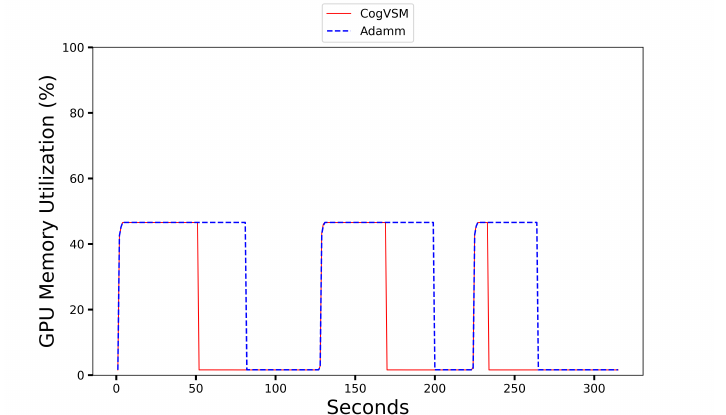
Figure 11. GPU memory utilization on a rural area video of the proposed CogVSM framework compared to the AdaMM framework ( θ m = 30 s for AdaMM).